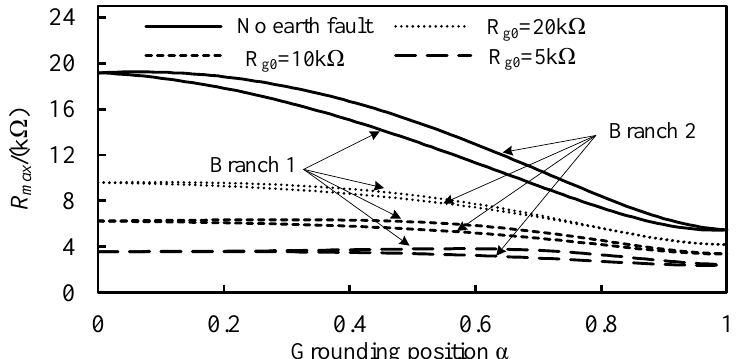
Figure 4. Sensitivity curves of the protection when the stator is already grounded by fault resistor R g 0 in the Petersen coil grounding mode.